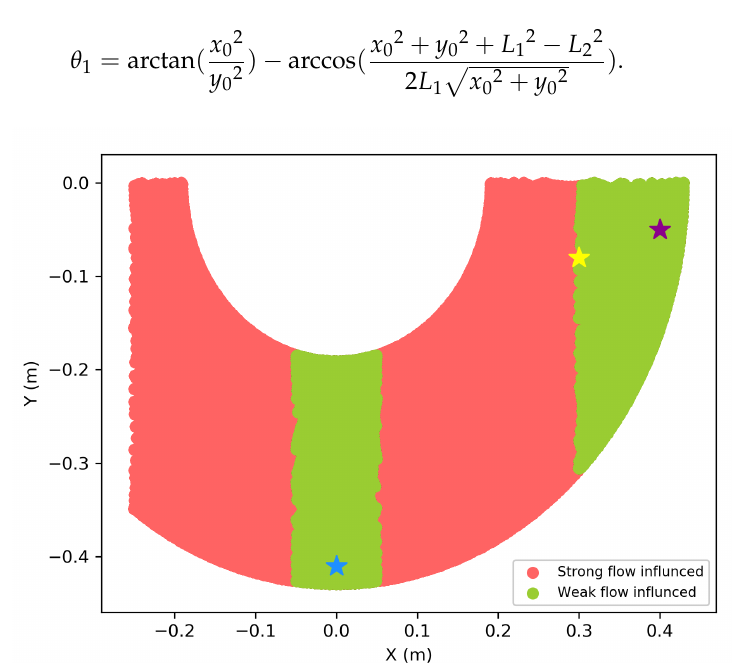
Figure 5. Workspace of robotic arm printed by using forward kinematics considered flow